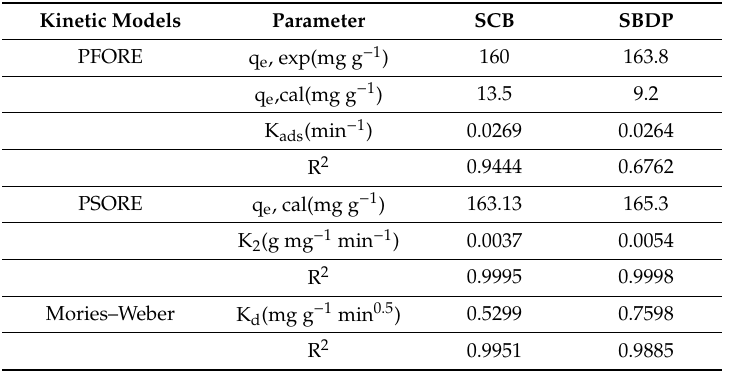
Figure 7. The adsorption kinetics: ( A ) pseudo first-order reaction (PFORE), ( B ) pseudo second-order reaction (PSORE), ( C ) Mories–Weber equation for Ni(II) adsorption on SCB and SBDP nanocomposites (sorption time 40 min; sorbent dosage 0.3 g/50 m L, pH = 8). Table 1. kinetic modeling with the PFORE, PSORE, and Mories–Weber